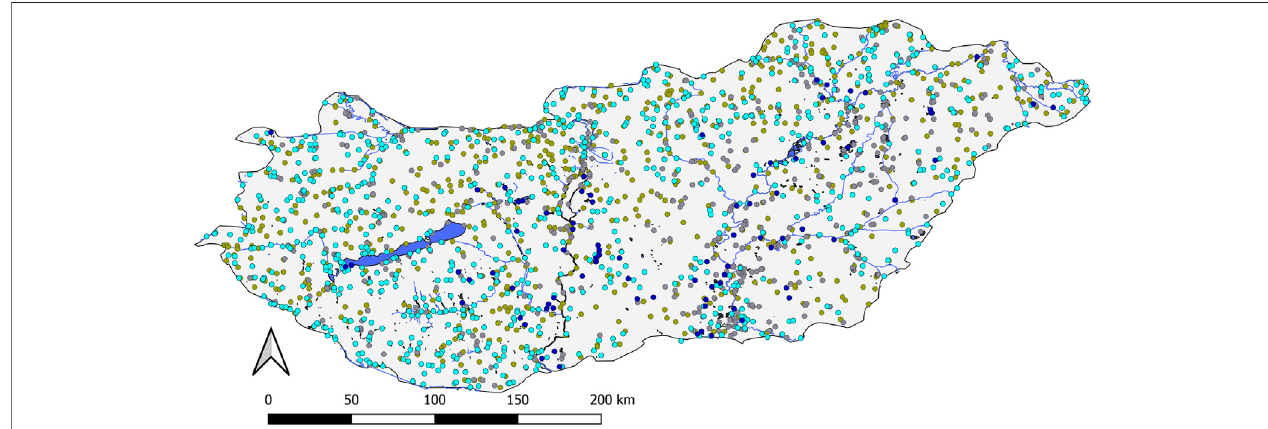
FIGURE4| Thelocationofthemonitoringpointsandpollutionsources-cyanbluenodesrepresentthemonitoringpointsofwatercourses,darkbluenodesreferto the location of monitoring points of lakes, nodes marked in green denote the location of the municipal wastewater treatment plants (WWTPs), and grey nodes show the locations of industrial emission